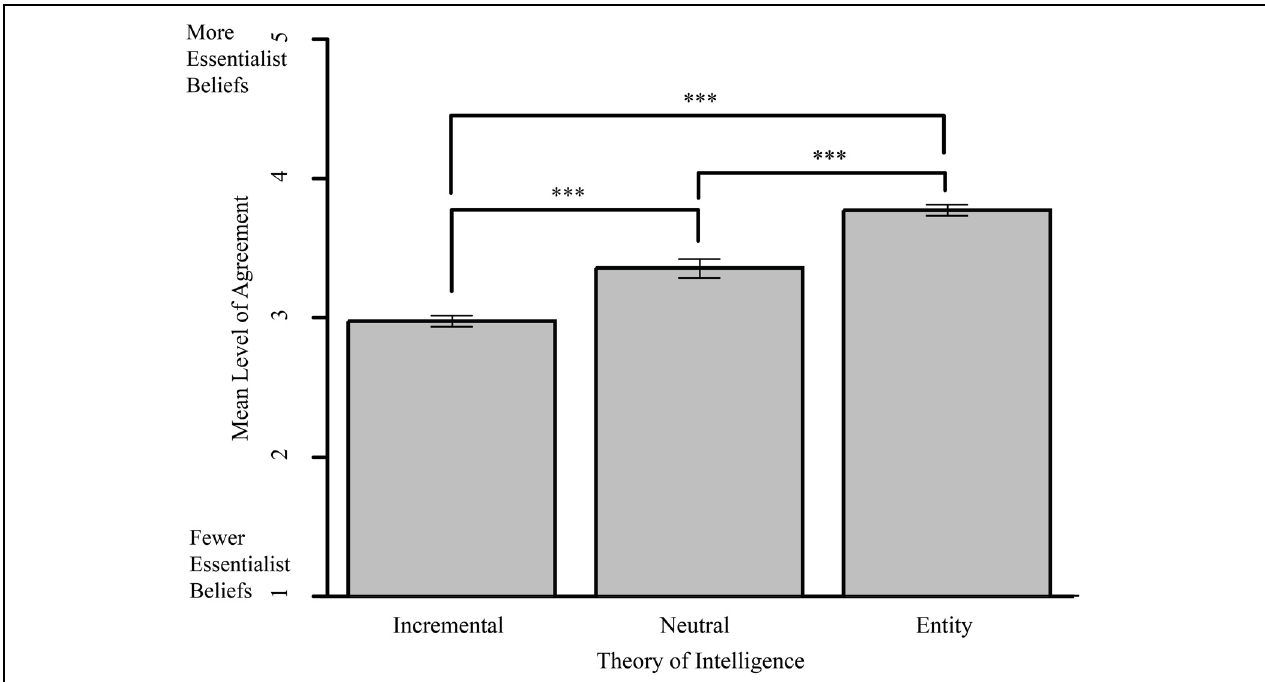
FIGURE 1 | Essentialism scoresby theory of intelligence (TOI). Mean level of agreement with statements such as “People who have intelligence will tend to display it in a consistent manner, showing it in different situations and with different people,” by participants in the different TOI groups. Error bars indicate SE. ∗∗∗ p < 0.001.